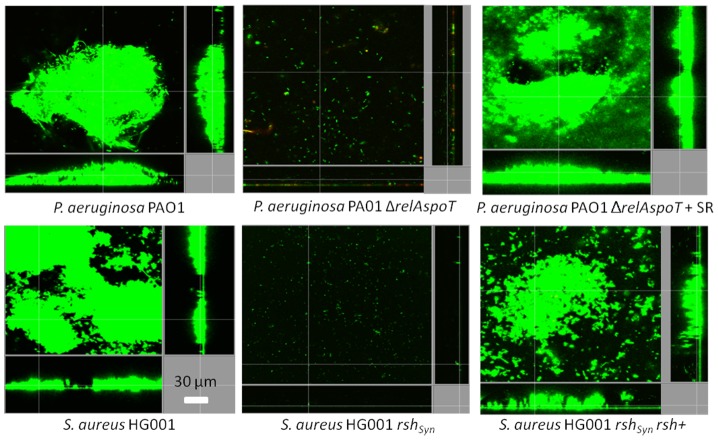
Genetic complementation of (p)ppGpp synthetase enzymes restored the ability to form biofilms.The biofilm deficiency of Pseudomonas aeruginosa PAO1 and Staphylococcus aureus HG001 (p)ppGpp mutants (ΔrelAspoT and rshSyn respectively) was rescued by genetic complementation [ΔrelAspoT + relAspoT+ (+SR) as described [12] and rsh+
[30], respectively] leading to biofilm formation equivalent to WT shown in the left-most panels. After 3 days, bacteria were stained green with the all bacteria stain Syto-9 and red with the dead-bacteria stain propidium iodide (merge shows as yellow to red) prior to confocal imaging. Each panel shows reconstructions from the top in the large panel and sides in the right and bottom panels (xy, yz and xz dimensions).